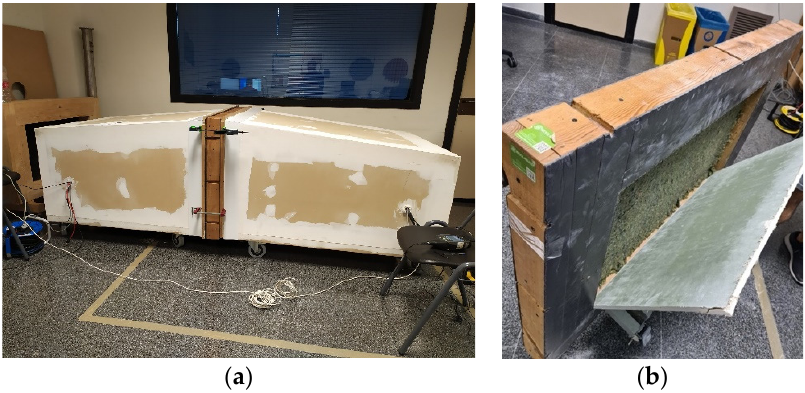
Figure 6. Setup for the sound transmission tests: ( a ) the transmission chamber during one of the tests; ( b ) detail of one of the tested configurations placed in the sample holder.